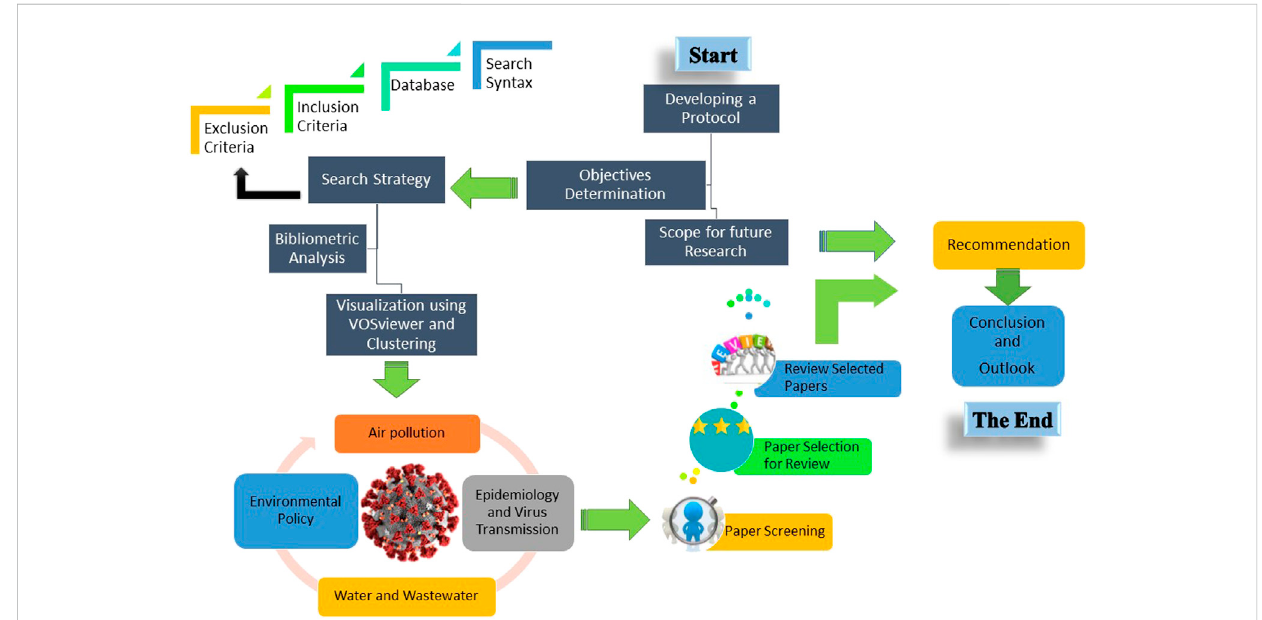
FIGURE 1 The general framework of the present studies. The research structure described in Section 2 includes the study ’ s main objectives, search strategies, and methods for describing and systemizing the literature. Section 3 presents the descriptive analysis of relevant papers and continues with the knowledge and research trends, speci fi cally, the scope for future research regarding COVID-19, suggestions for upcoming research, and restrictions on machine learning (ML). Finally, Section 4 presents the conclusion and